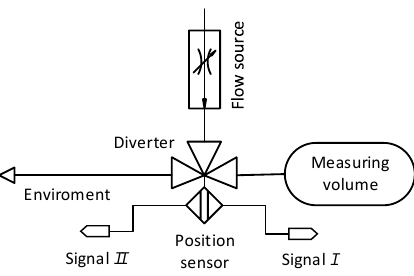
Figure 1. Schematic representation of a diverter.